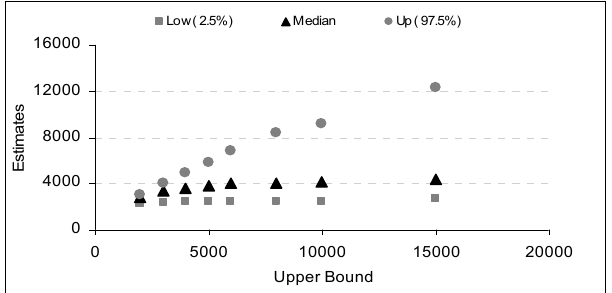
Figure 1 – Dataset A) Independence among sources and significant effect of continuous covariate: non parametric point estimates of the population size and 95% C.I. according to the upper bound (Bayesian Capture-Recapture model).